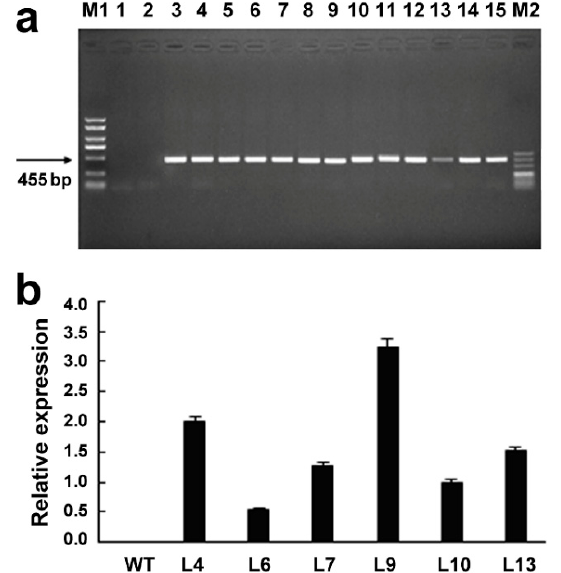
Figure 4. Molecular identification for GsMAS1 transgenic lines in Arabidopsis. ( a ) PCR identification of GsMAS1 transgenic plants. ( b ) qRT-PCR identification of GsMAS1 transgenic lines. The 3-week-old seedlings of Arabidopsis were used to identify GsMAS1 transgenic plant and lines. M1: DNA maker DL5000; M2: DNA marker DL500; Lanes 1–15: PCR products with different DNA templates set as ddH 2 O for lane 1, genomic DNA from wide type for lane 2, genomic DNA from GsMAS1 transgenic plants for lanes 3–15. WT: wild type of Arabidopsis Columbia-0; L4 to L13: six transgenic lines of GsMAS1 in T 3 generation. Data are means ± SE. Error bars represent the standard error of four replicates.